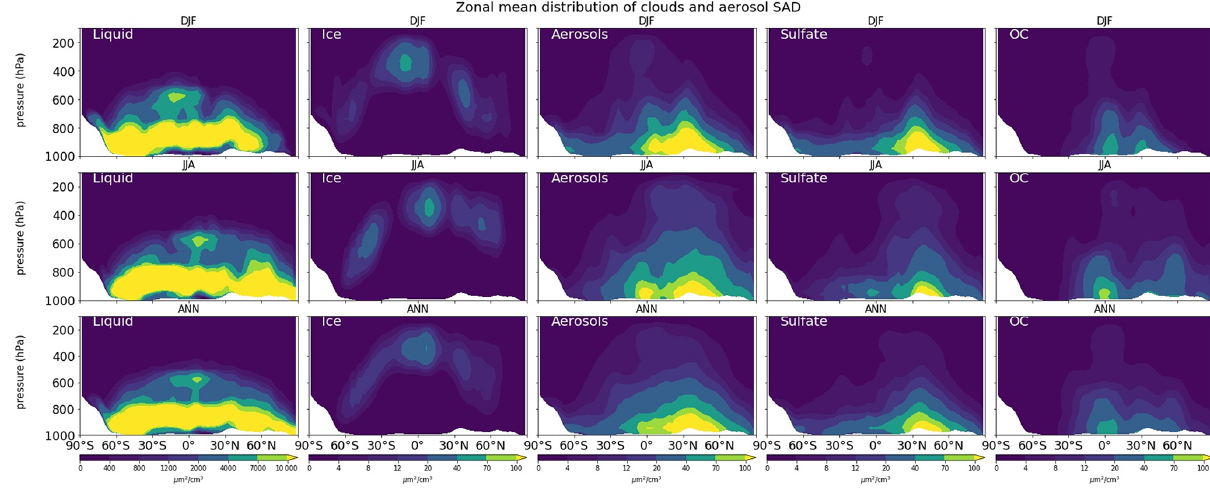
Figure 8. Zonal, seasonal mean (upper and middle), and annual mean (lower) distribution of cloud droplet surface aerosol density (SAD), cloud ice SAD, total aerosol SAD, sulfate aerosol SAD, and organic carbon SAD (from left to right).